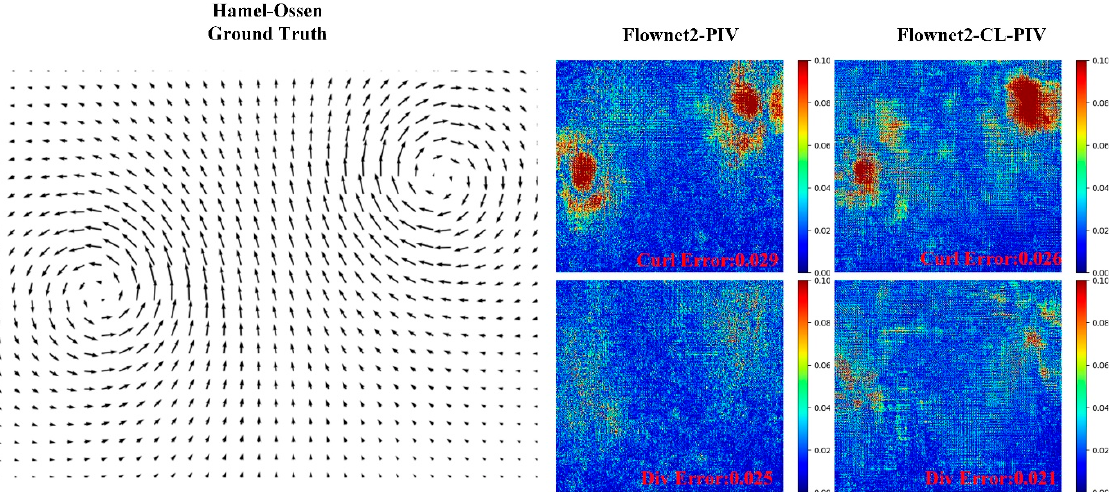
Figure 7. Div-curl error of two methods on the Hamel-Ossen flow field.